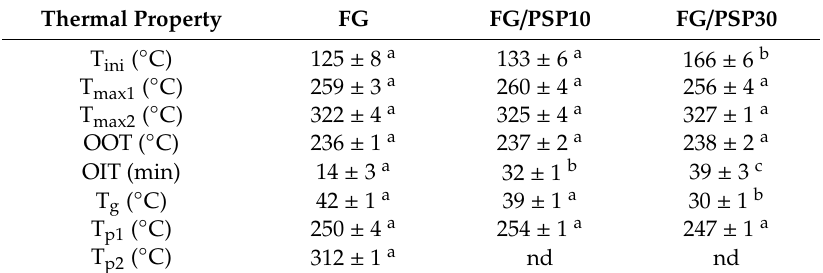
Table 4. Thermal parameters obtained for bio-composite films ( n = 3, mean ± SD).